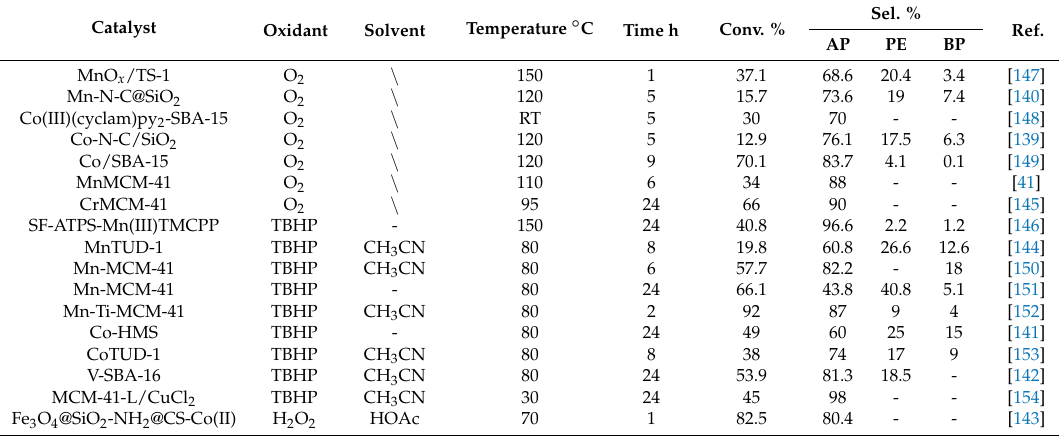
Table 3. Catalytic properties of different catalysts on ethylbenzene